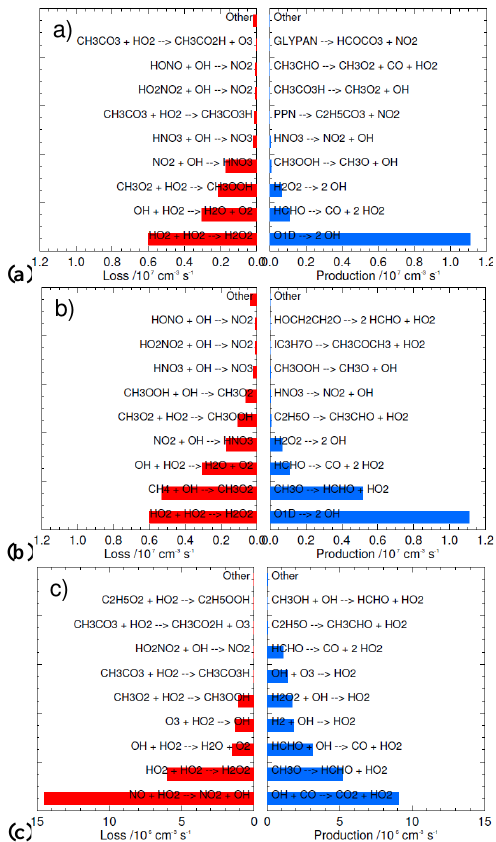
Fig. 10. Processes controlling the instantaneous production and loss of (a) RO x (b) HO x and (c) HO 2 for a typical data point in the Sahel boundary layer (shown in blue in Fig. 4). Species names are as given in the